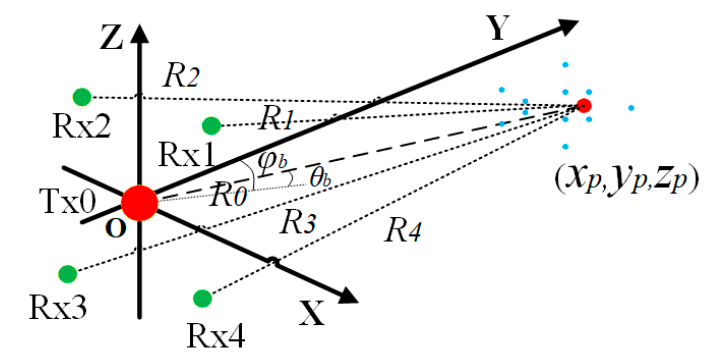
Figure 3. Geometry of the tracking and imaging scenario.